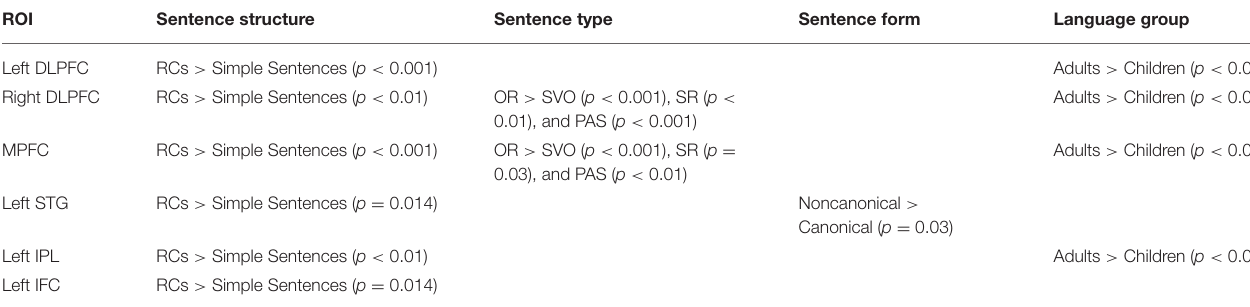
TABLE 6 | Main effects of sentence structure, sentence form, and age group across ROIs for bilingual adults and children.